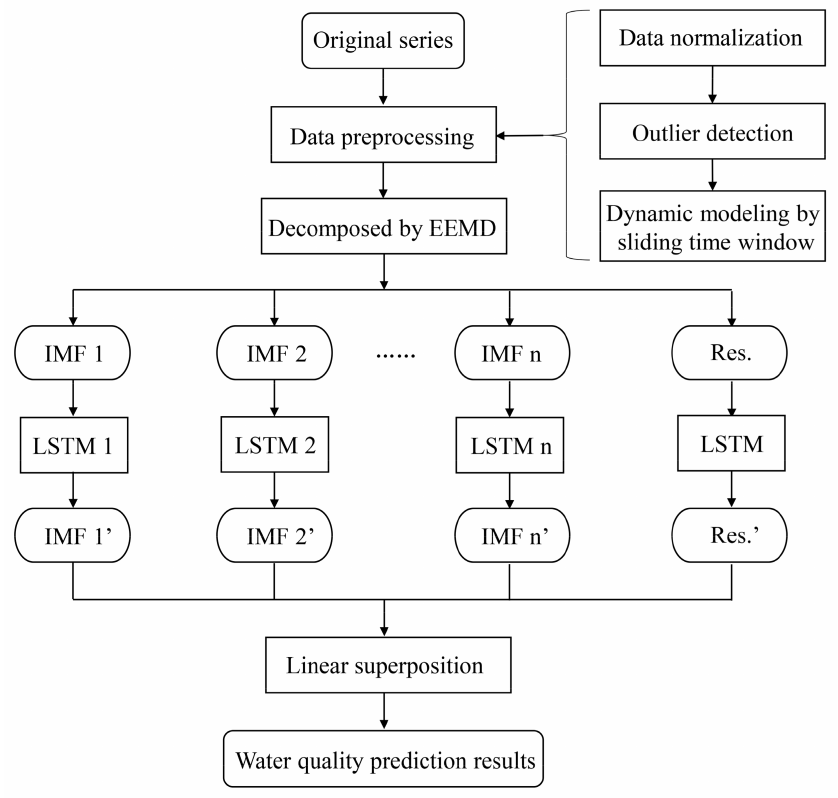
Figure 2. A schematic flowchart for